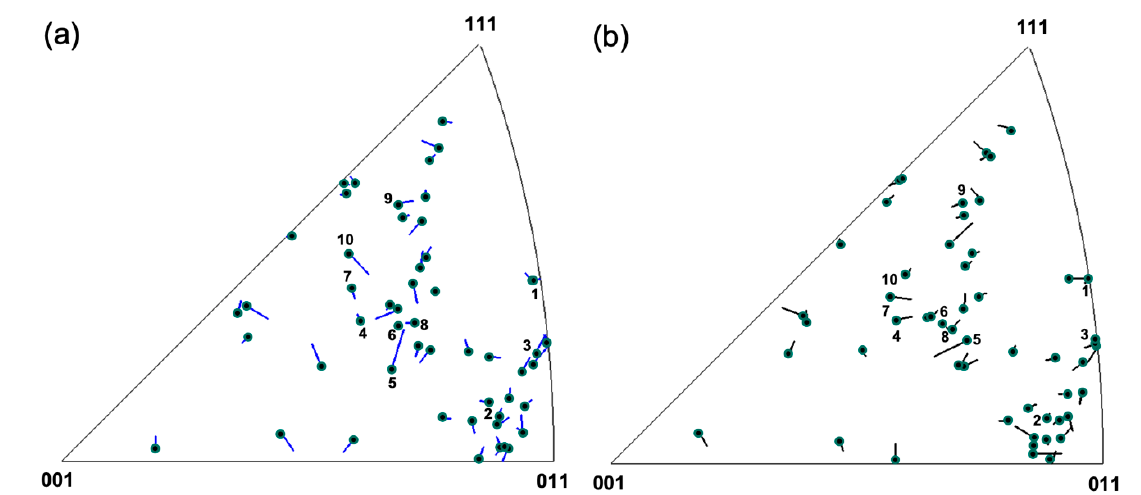
Figure 7. Inverse pole figures showing the final position of the loading axis of the grains labeled in Figure 2 together with vectors magnified four times representing the orientation change: ( a ) during loading from 3.6% to 4.8% strain and ( b ) during unloading from 5.1% to 3.6% strain. Vectors corresponding to grains 1 to 10 as in Figure 2b have been annotated.